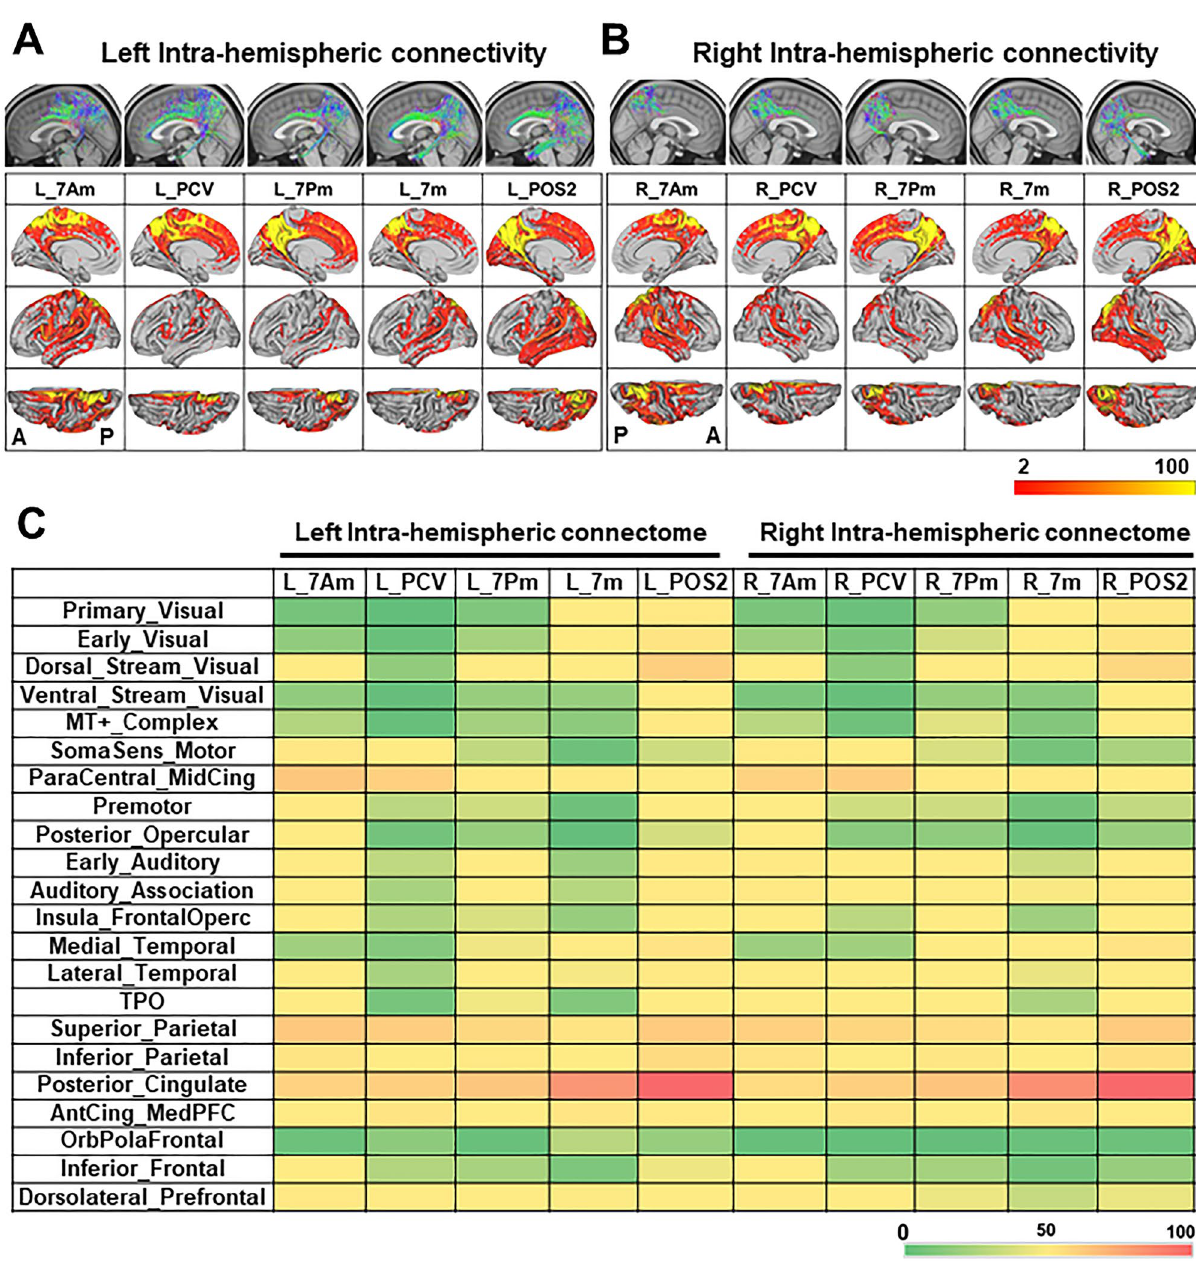
Figure 2. Intra-hemispheric structural connectivity (SC) of precuneus. ( A , B ) Tractogram and intra- hemispheric density map of streamline endpoint, seeded from each precuneus ROI by probabilistic tractography. Top panels are tractograms seeded from each precuneus ROI in the left ( A ) and right hemisphere ( B ), respectively. Brain regions with the density map of streamline endpoint were projected onto the group- average template brain (white matter surface) in the left ( A ) and right hemisphere ( B ), respectively. Medial, lateral, and top views of the hemisphere was shown in each lane. The color scale bar represents the group- average endpoint count/voxel (range; 2–100). A, anterior; P, posterior. ( C ) Color map showing the intra- hemispheric group-average connection matrix of streamline count to connect each precuneus ROI (7Am, PCV, 7Pm, 7m, POS2) and the 22 Cortical Divisions of the HCP MMP atlas. The rows show the 22 Cortical Divisions of HCP MMP atlas, while the lines show the 5 precuneus ROIs in the left (L) and right (R) hemisphere, respectively. The color scale bar indicates the ratio (%) of maximum streamline count/area (i.e., R_Posterior_ Cingulate - R_POS2). The details of 22 Cortical Divisions in HCP MMP atlas are shown in Supplementary Fig. S2 with the